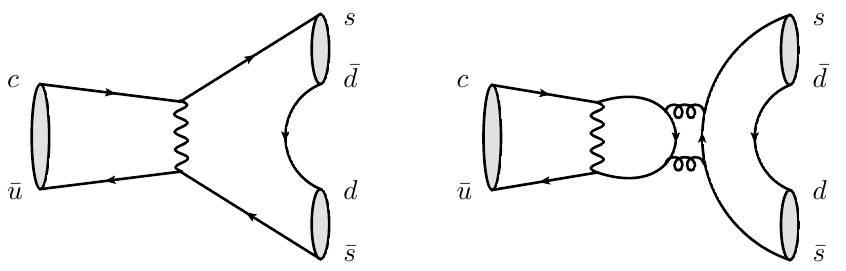
Figure 1 . Exchange (left) and penguin annihilation (right) diagrams contributing to the D 0 ! K 0 K 0 amplitude. Based on ref. S S